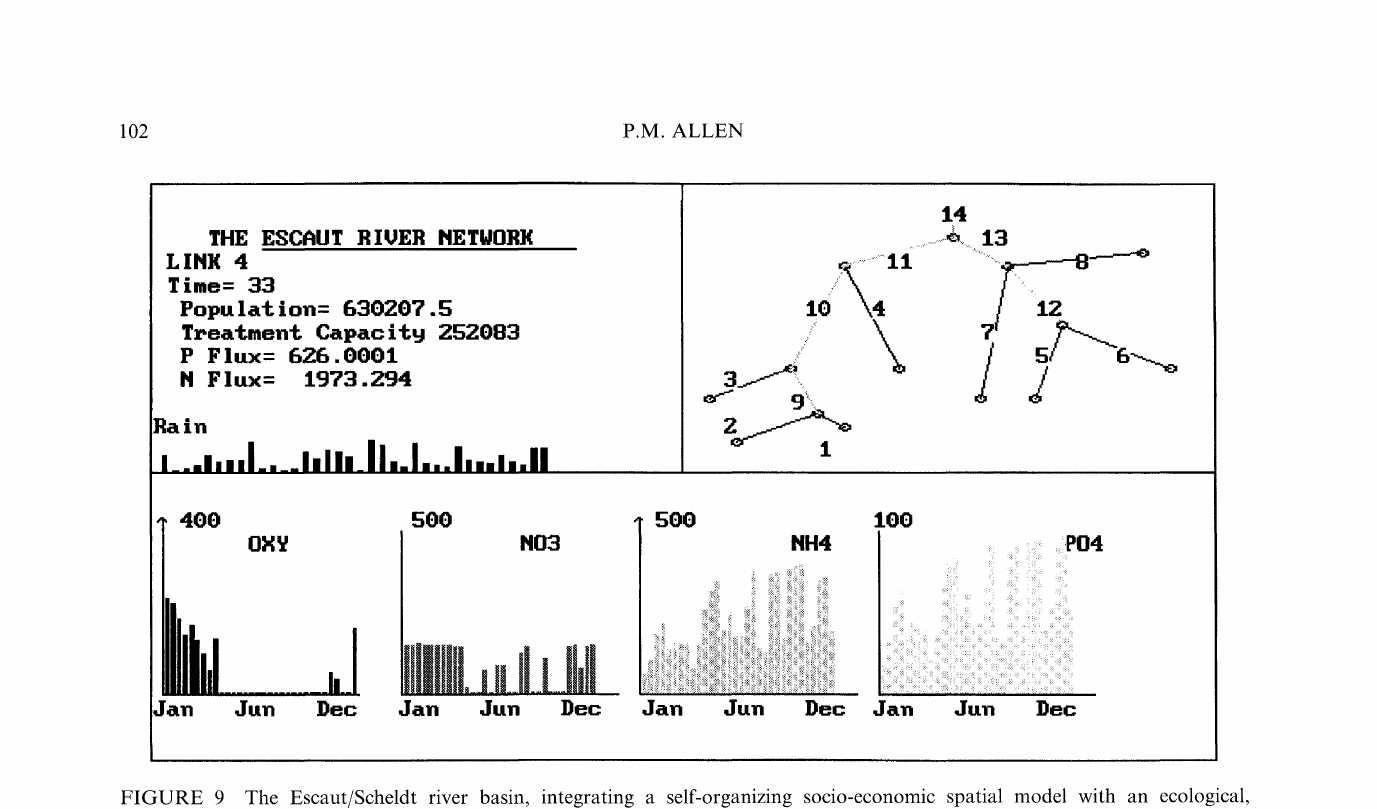
FIGURE 9 The Escaut/Scheldt river basin, integrating a self-organizing socio-economic spatial model with an ecological, biochemical and hydrological river model for environmental policy